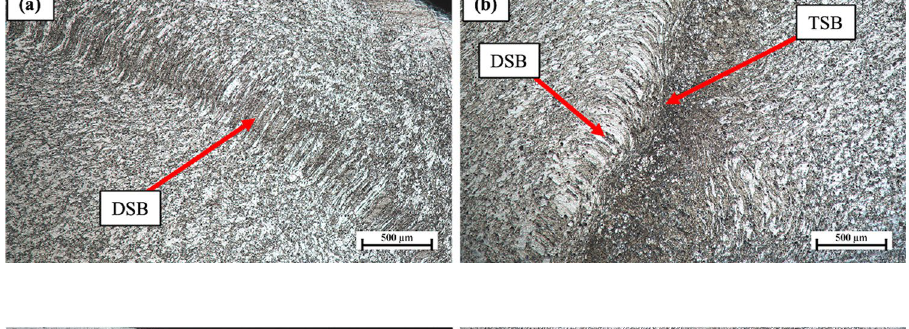
Fig. 9 OM images showing the origination of DSB from initial arc-shaped grains in the specimens deformed with ( a ) 2000s −1 at 200 °C and ( b ) 3200 s −1 at 300 °C